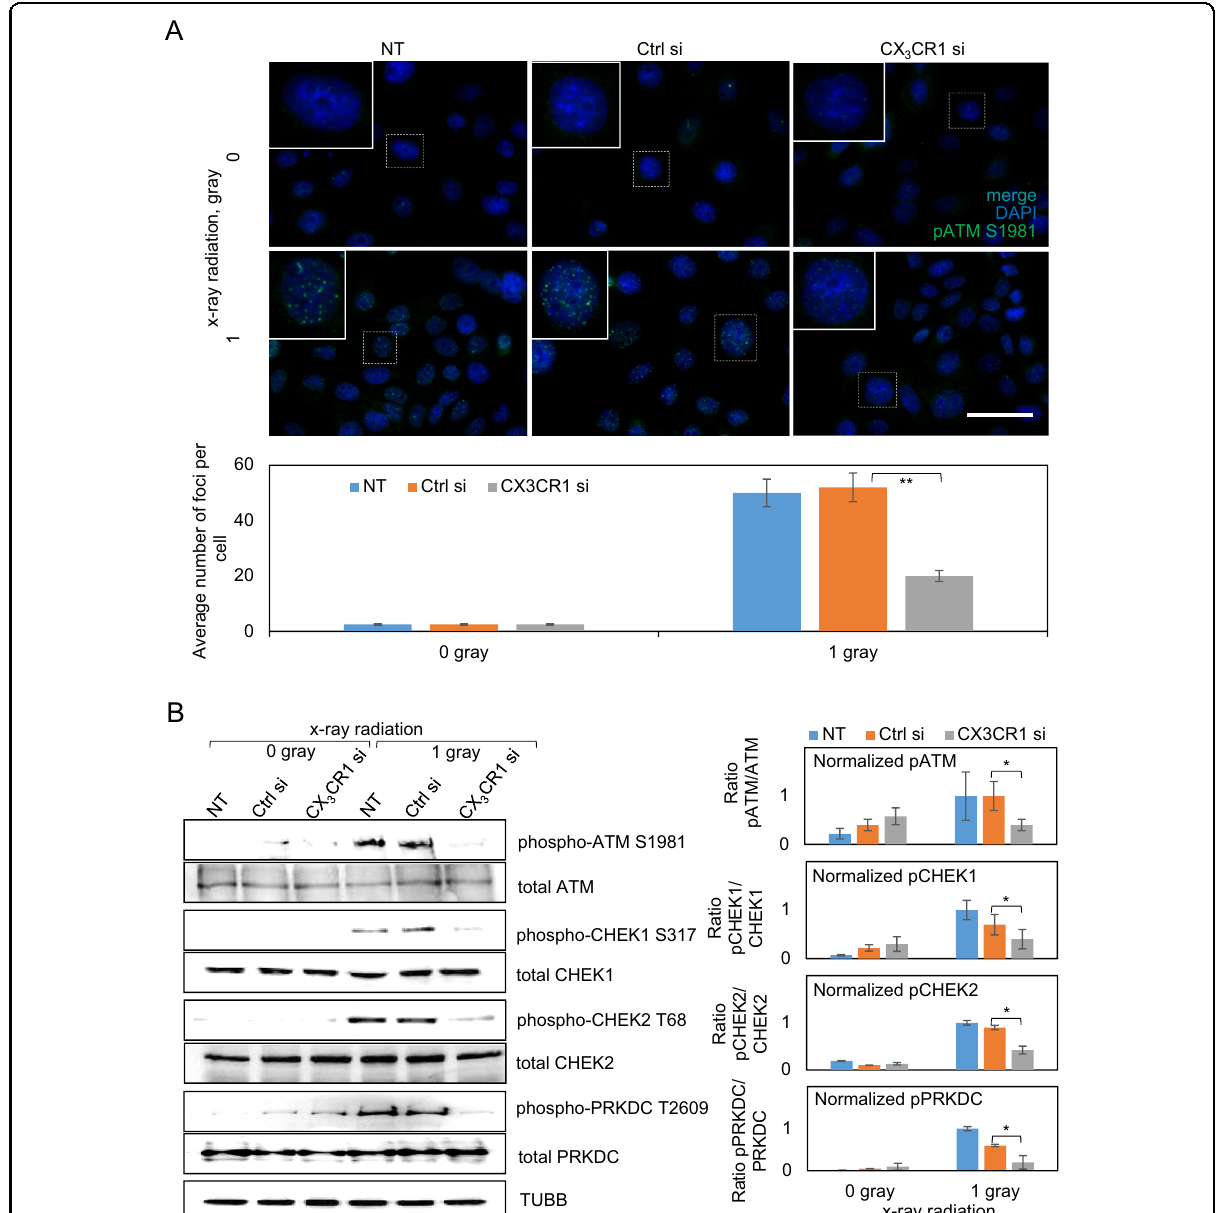
Fig. 4 Downregulation of CX 3 CR1 leads to reduced activation of DNA damage repair-related kinases in irradiated HGSOC cells. OVCAR-4 was transiently transfected with either CX 3 CR1-speci fi c (designated “ CX 3 CR1si ” ), control (designated “ Ctrl si ” ), or vehicle (designated “ NT ” ) and subjected to 0 or 1 gray x-ray on the 3 rd day following transfection. ( a ) Cells were seeded on glass coverslips. Expression of phosphorylated ATM (at Ser1981) was examined with immuno fl uorescence staining. Nuclear DNA was stained using DAPI. Images superimposed from blue and green channels are shown. Number of pATM-positive foci (green fl uorescence) was quanti fi ed for three independent experiments using Zeiss Axiovert software and plotted. * p < 0.05, Student ’ s t test. Bar, 25 μ m. Nuclei outlined with dotted lines were enlarged and shown in the upper left corners of the corresponding images. b Expression of phospho-ATM (Ser1981), total ATM, phospho-CHEK1 (Ser317), total CHEK1, phospho-CHEK2 (Thr68), total CHEK2, phospho-PRKDC (Thr2609), and total PRKDC was examined with western blot, and three independent experiments were quanti fi ed using digital densitometry, averaged, and plotted; TUBB was used as a loading control. Normalized expression of phospho-ATM, phospho-CHEK1, phospho- CHEK2, and phospho-PRKDC was quanti fi ed with digital densitometry and plotted. * p < 0.05, Student ’ s t